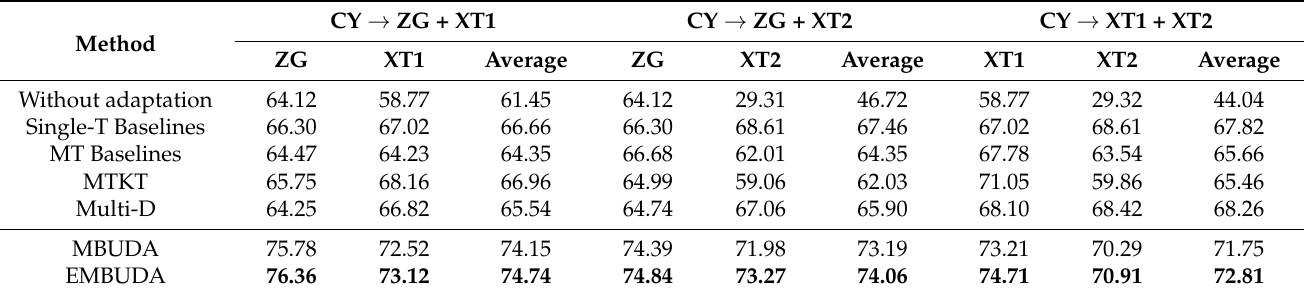
Table 4. The IoU of orchard area segmentation when Dataset CY is set as the source domain.